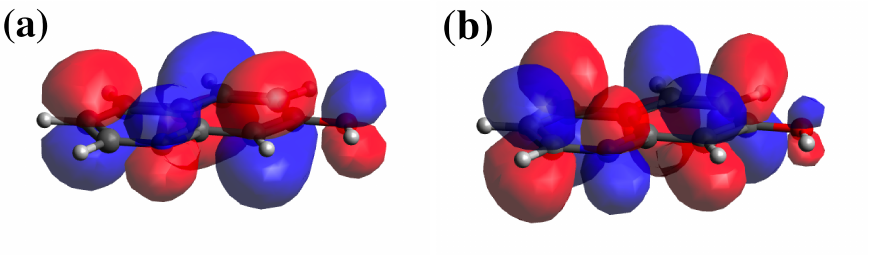
Figure 2. ( a ) HOMO and ( b ) LUMO orbitals of 7HQ photoacid at ground state calculated at DFT level.